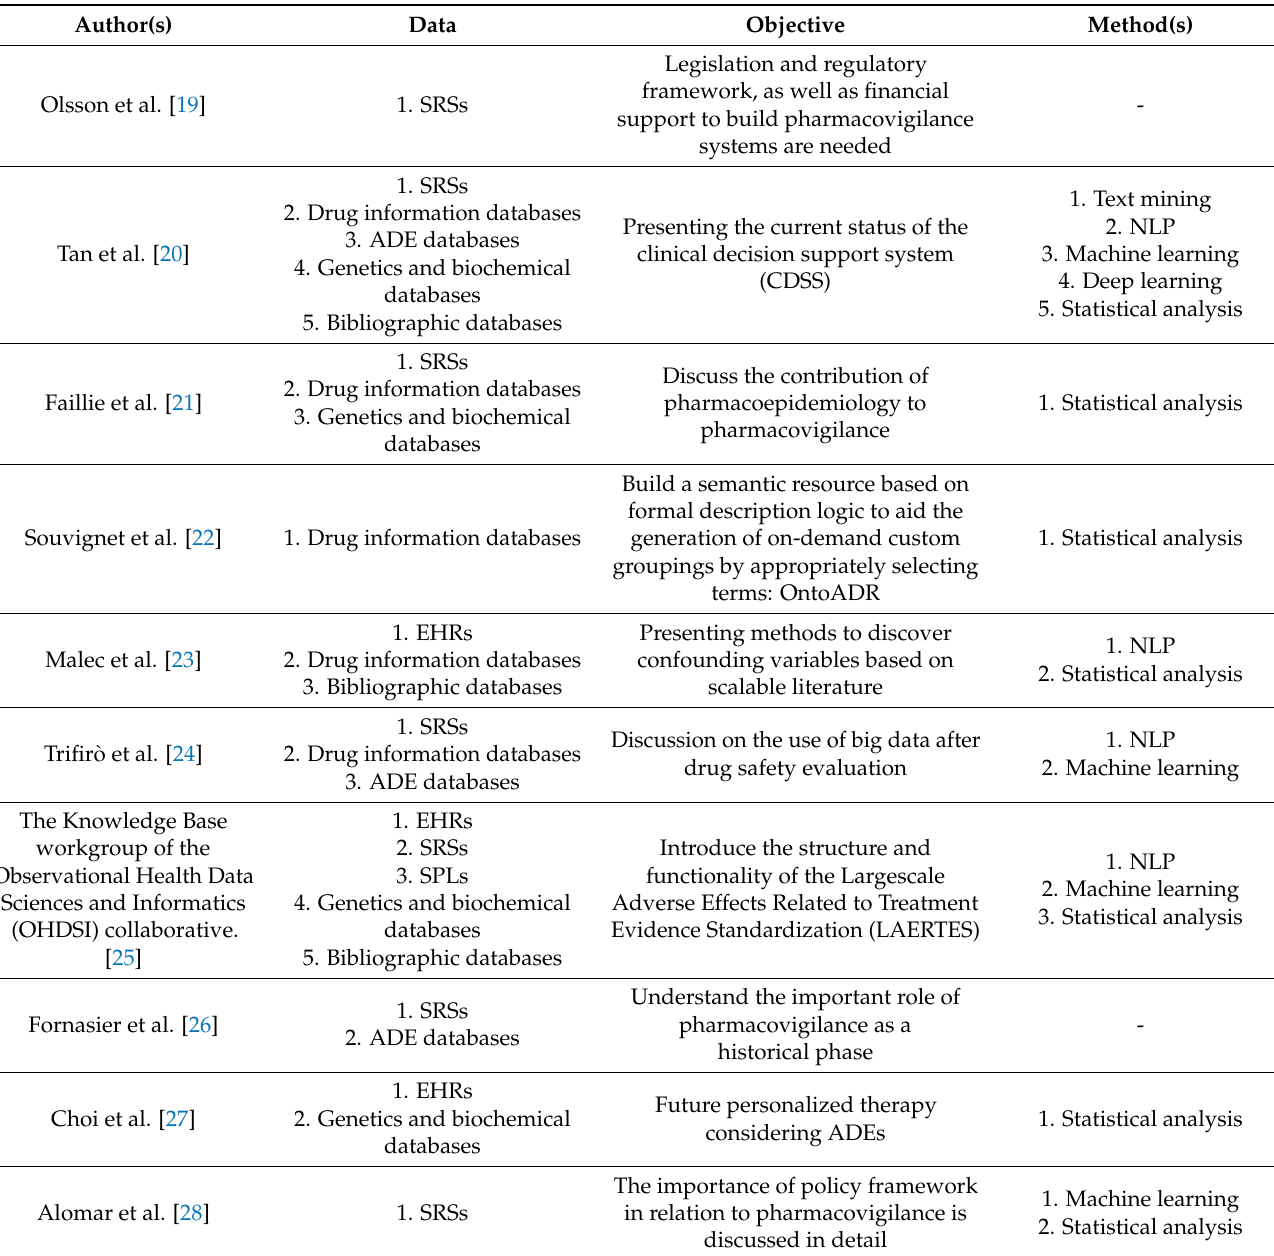
Table 2. Selected papers and their sources of data for determining drug safety